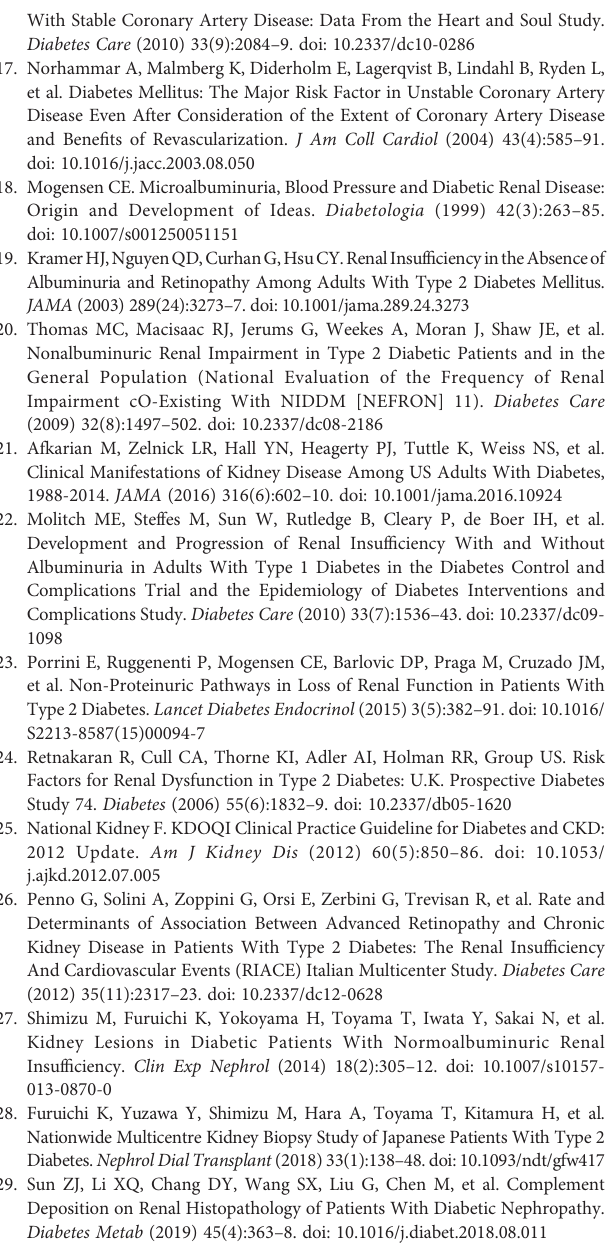
Supplementary Table 1 | Clinical features of DN patients with non-diabetic renal disease (NDRD) and without NDRD. Values are expressed as a mean ± standard deviation, percentage or median with upper and lower quartile or percentage. Chi- square tests were performed in percentages or ratios variables. T-tests were performed in normally distributed variables. semi-quantitative and quantitative parameters that were not normally distributed were assessed using Kruskal-Wallis or Mann-Whitney